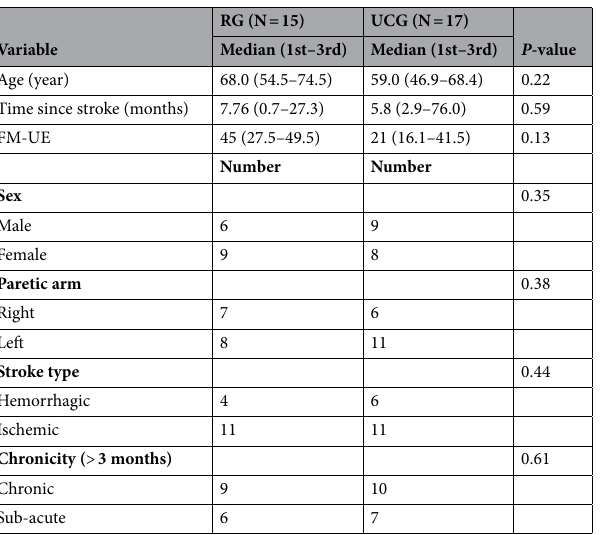
Table 1. Demographic and clinical features of study participants. FM-UE: Fugl-Meyer Motor Assessment for the Upper Extremities. P -values indicate the results of Mann–Whitney U Test for age and time since stroke, of unpaired t-test for FM-UE and of the Fisher exact test for all the other variables.